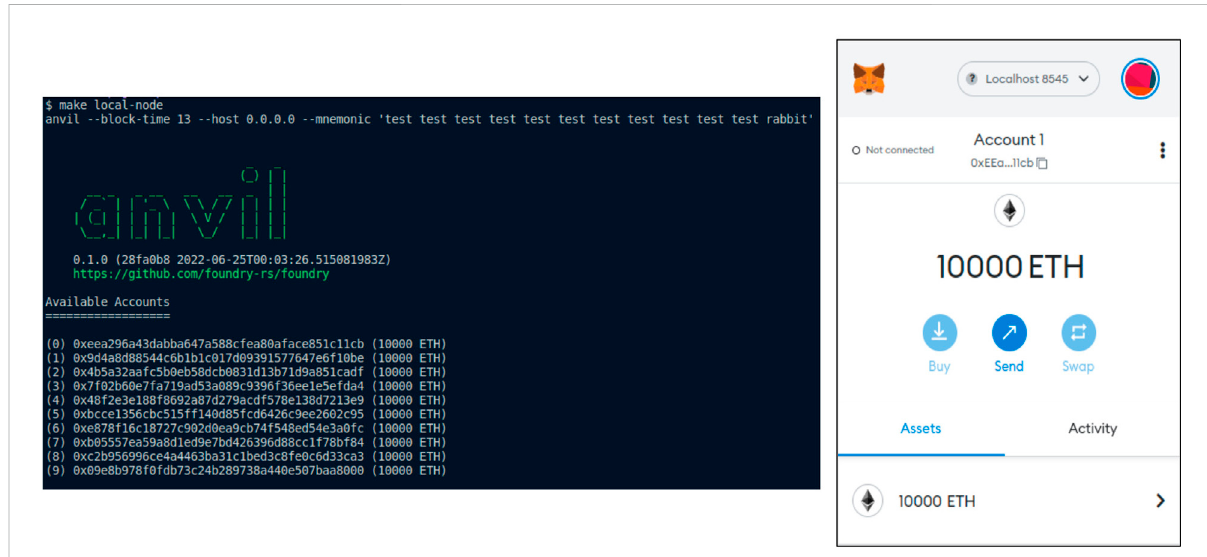
FIGURE 3 Left:TheAnvillocalchain. Right:TheMetamaskwalletextension. The accountsaregenerated basedonthegiven mnemonic phrase.The block time is set at 13 s to simulate the Ethereum